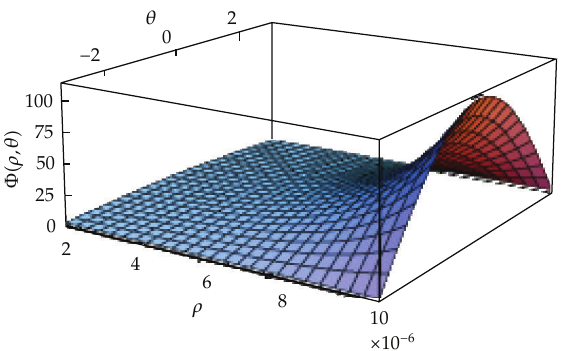
Figure 2: Adimensional plot of the mapping Φ considered in (cid:5) 2.9 (cid:6) , for (cid:5) ρ,θ (cid:6) ∈ (cid:3) h ; r (cid:3) × (cid:3) − π ; π (cid:3) . The plotted surface illustrates the qualitative behaviour as function of the radius ρ and the angle θ , at the input site (cid:5) x (cid:10) 0 (cid:6) and the initial instant of time (cid:5) t (cid:10) 0 (cid:6) (cid:5) this figure was produced by Mathematica 5.2, developed by Wolfram Research (cid:6)